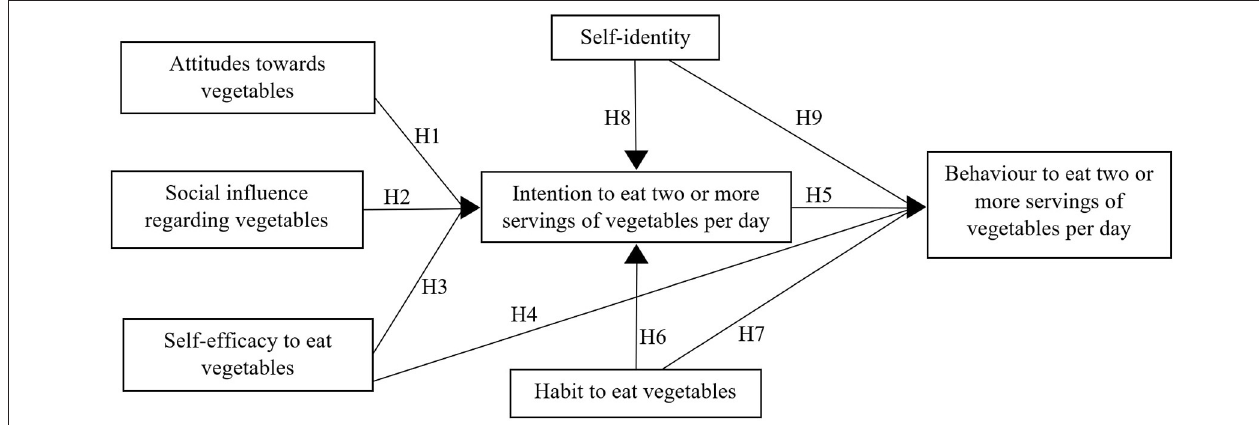
FIGURE 1 | Proposed theoretical framework for determining daily intake of two or more servings of